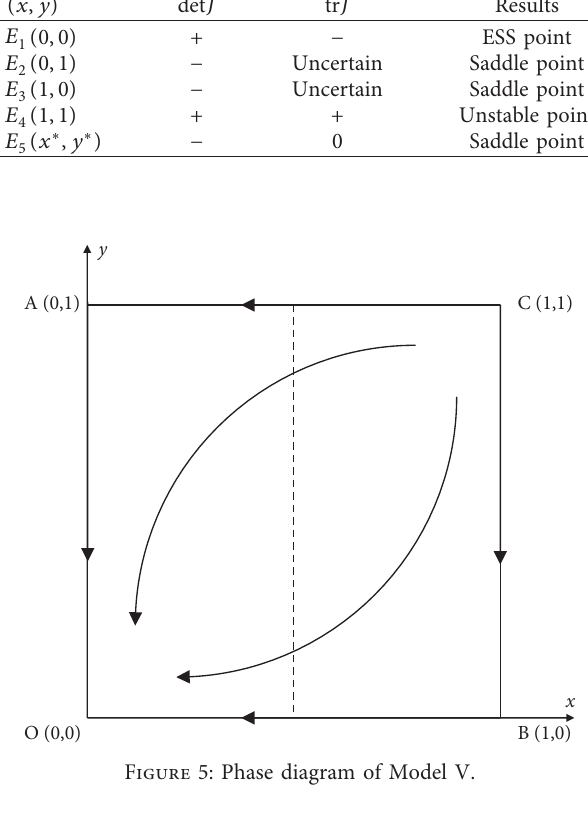
Figure 5: Phase diagram of Model V.